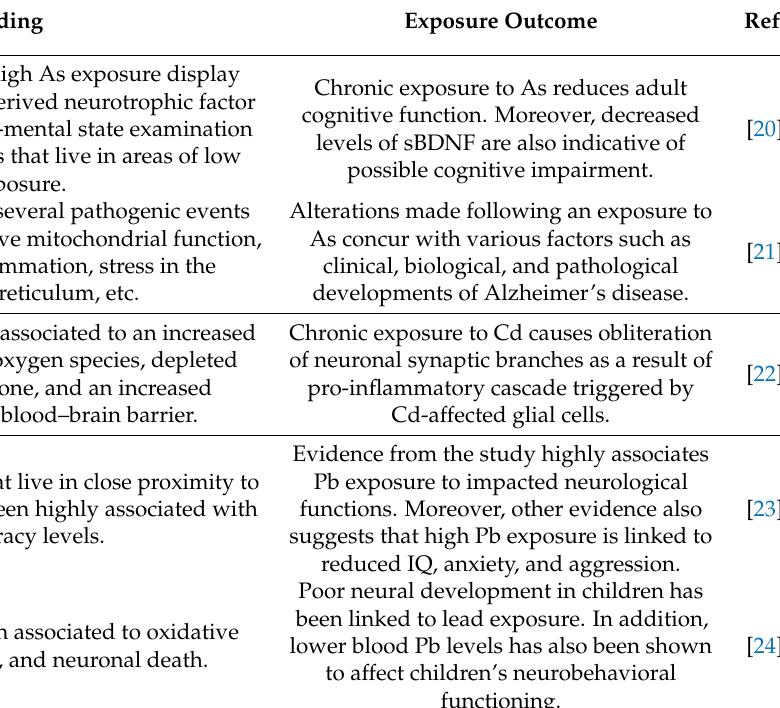
Table 1. A selected sample of existing scientific evidence on the effects of heavy metal exposure to the human brain. Finding Exposure Outcome